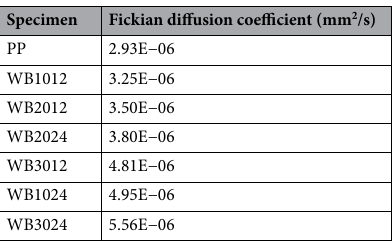
Table 4. Fickian diffusion coefficient values of PP and GFRPP with different fiber contents and lengths.